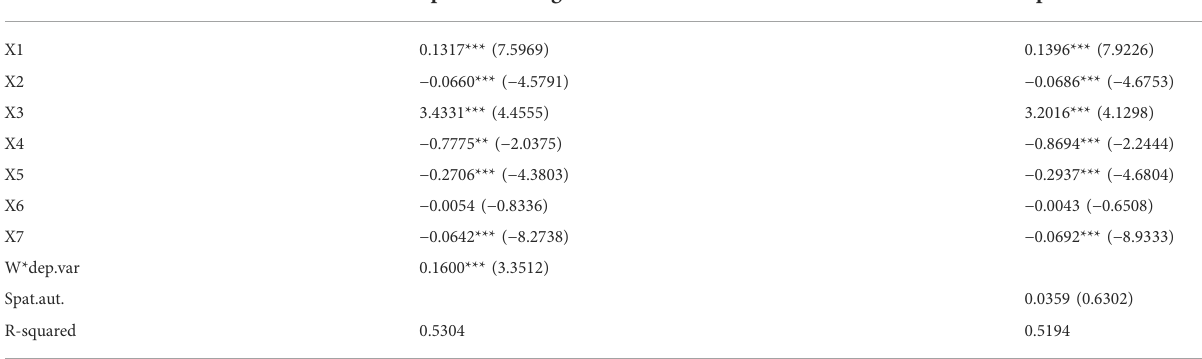
TABLE 6 Estimation and test results of spatial econometric model (Time fi xed effect).